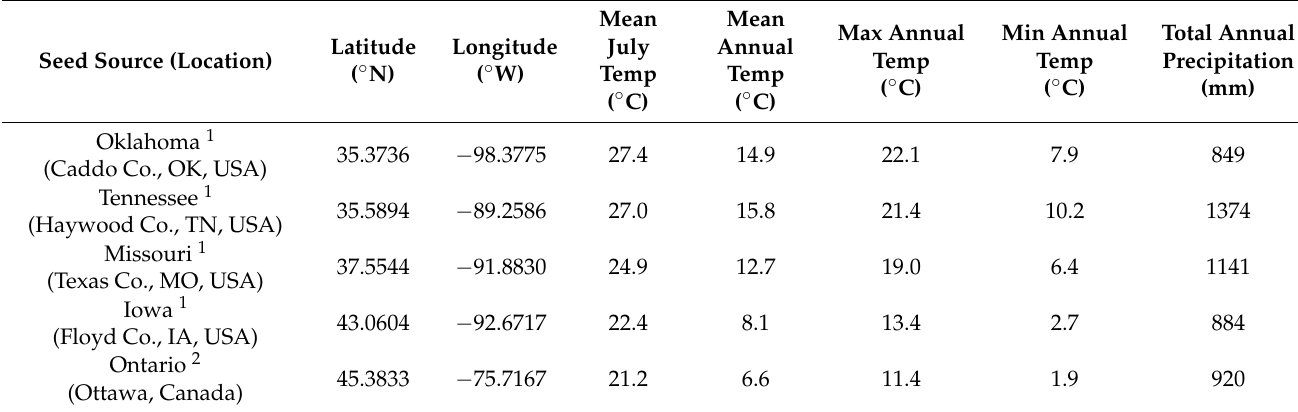
Table 1. Sources of Acer saccharum subsp. saccharum and Acer saccharum subsp. nigrum (Iowa), approximate location, and climatic conditions.